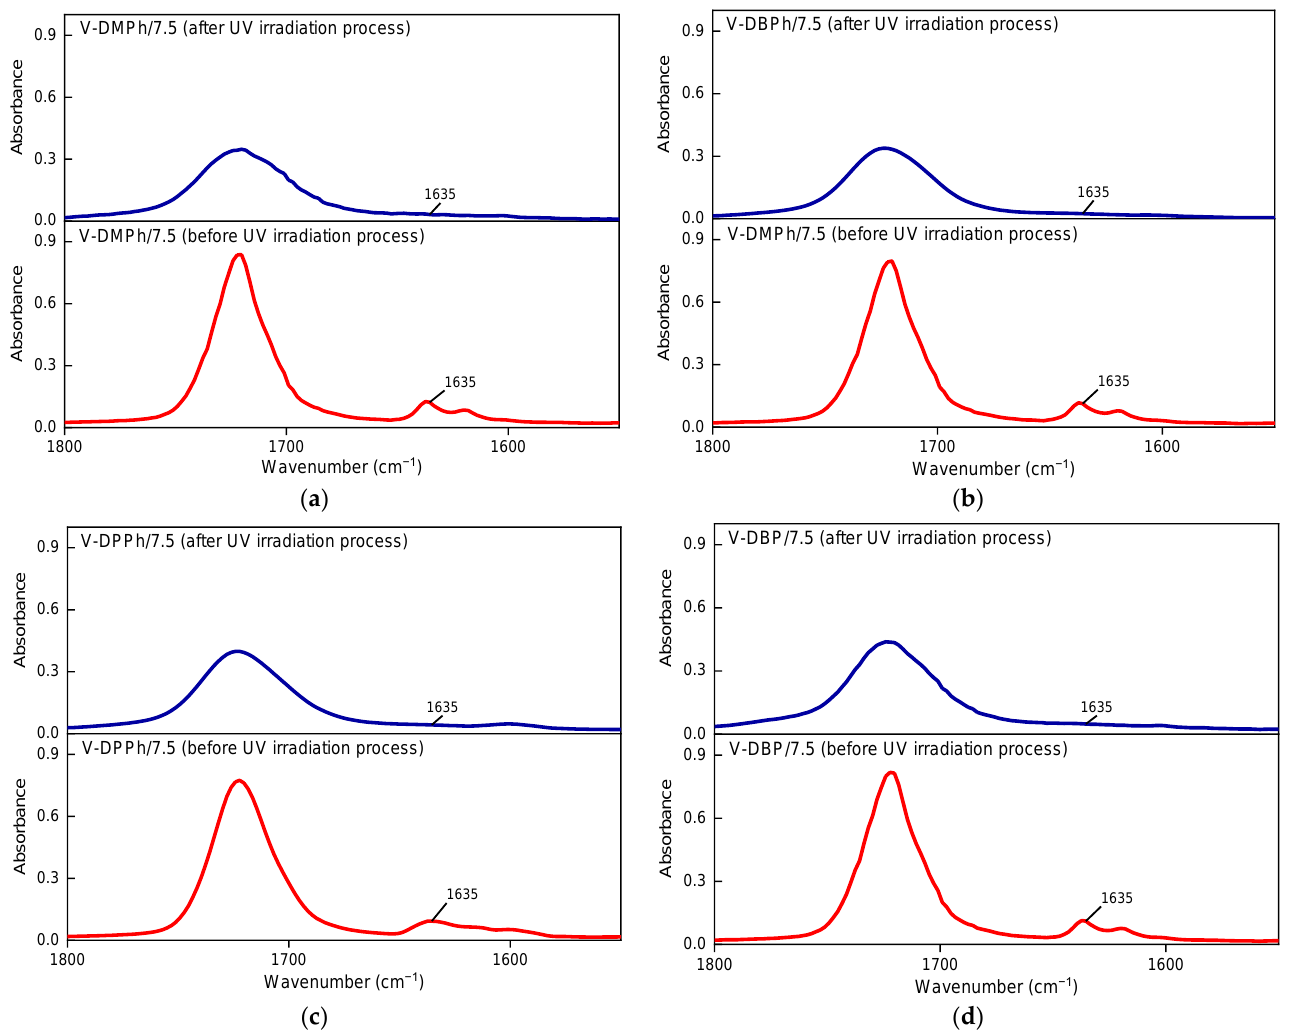
Figure 6. The FTIR spectra of UV-cured varnish coatings (before and after the UV irradiation process): V-DMPh/7.5 ( a ); V-DBPh/7.5 ( b ); V-DPPh/7.5 ( c ); V-DBP/7.5 ( d ).